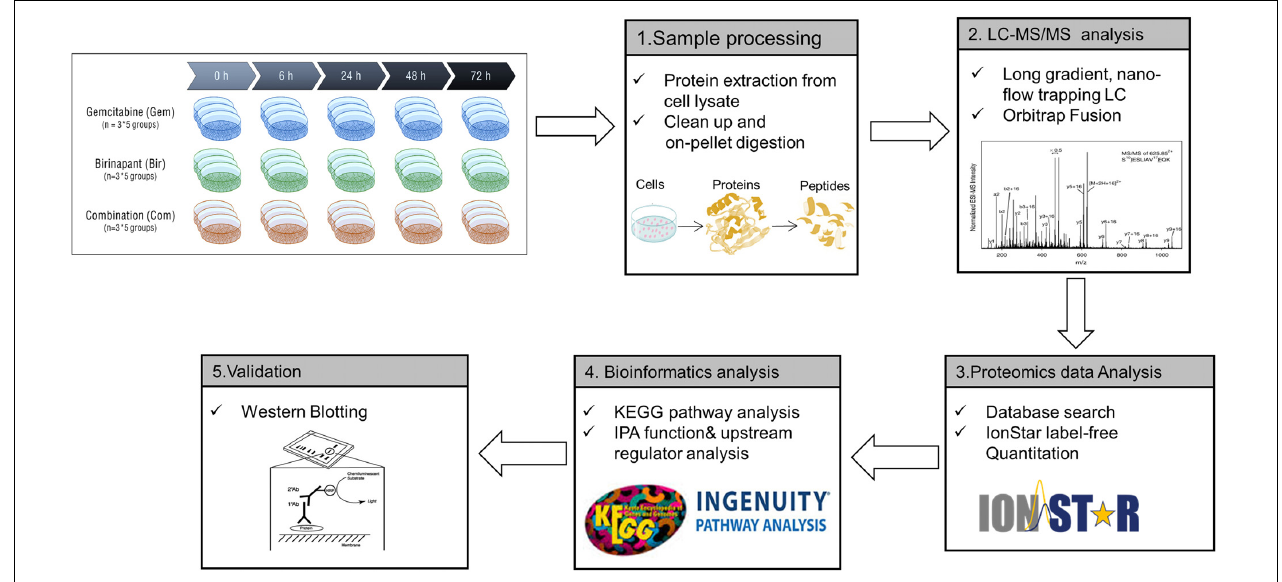
FIGURE 1 | Work flow of the proteomic